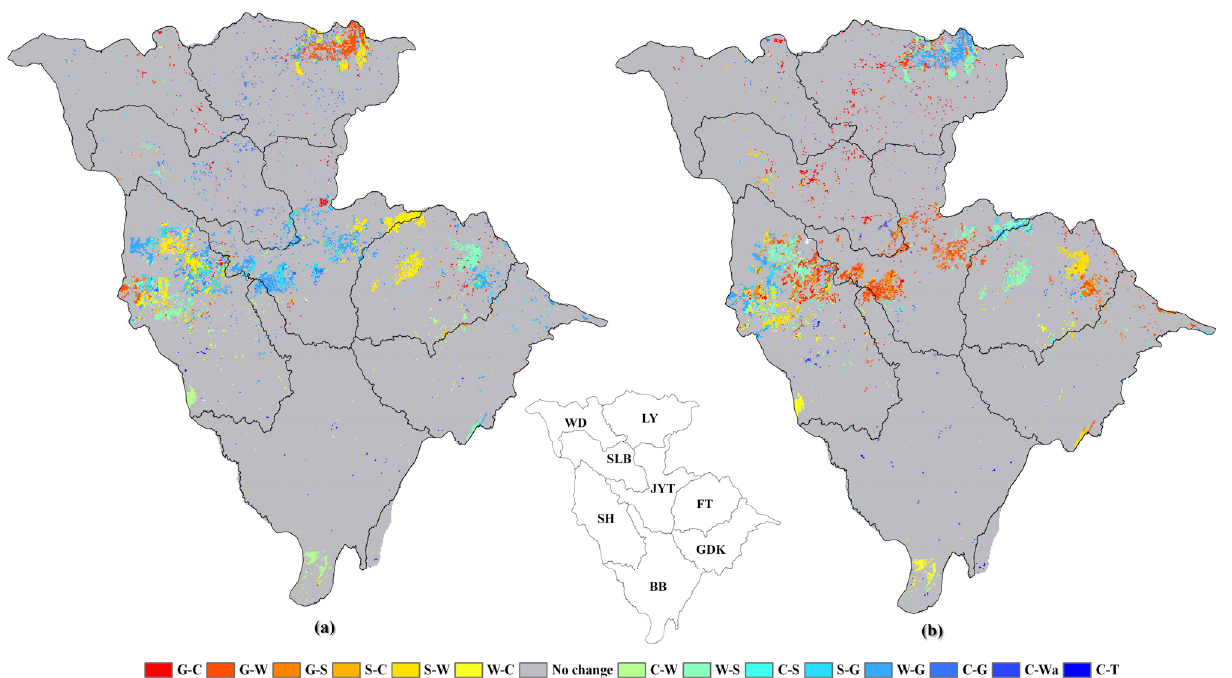
Figure 2. Spatial land use changes in the Jialing River Basin: ( a ) land use changes from 1985 to 1995 and ( b ) land use changes from 1995 to